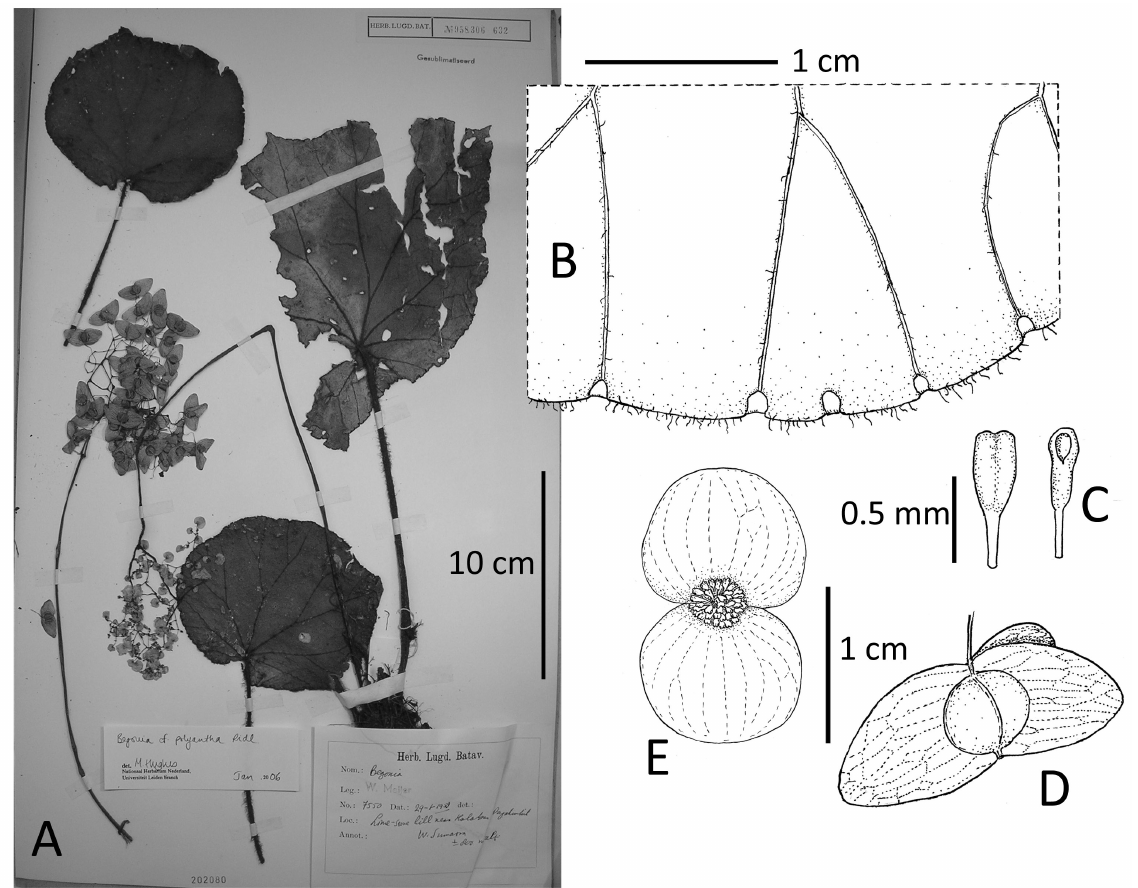
Fig. 5. Begonia halabanensis M.Hughes sp. nov. A . Holotype [ Meijer 7550 (L)]. B . Portion of leaf lamina underside showing margin hairs and recurved teeth. C . Anthers. D . Fruit. E . Male flower. Drawings by M.